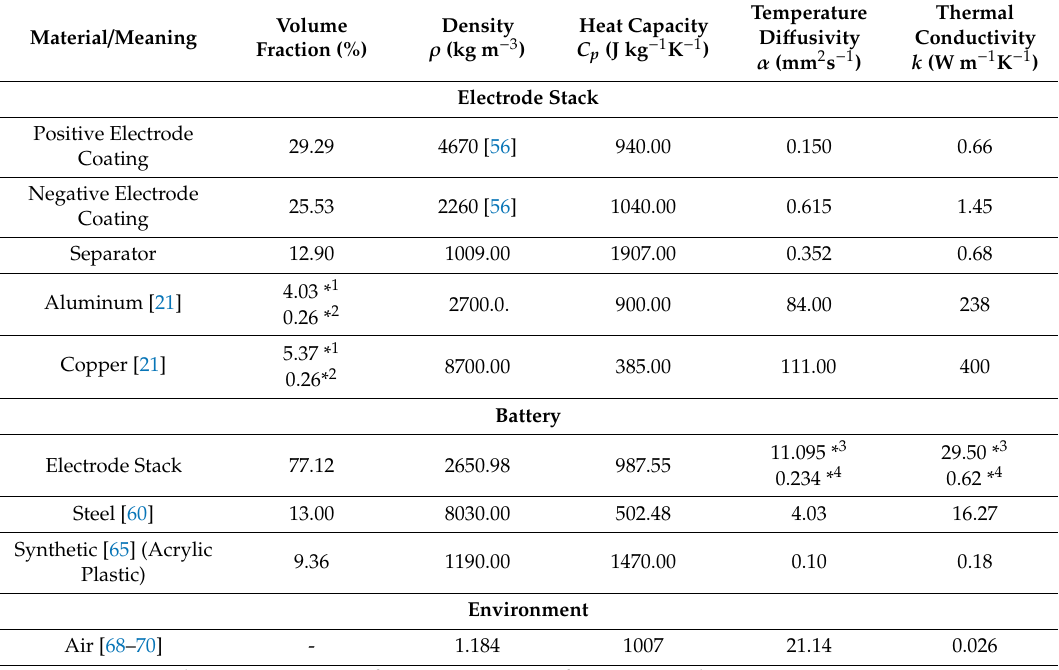
Table 1. The thermophysical properties of all components at the 25 ◦ C reference